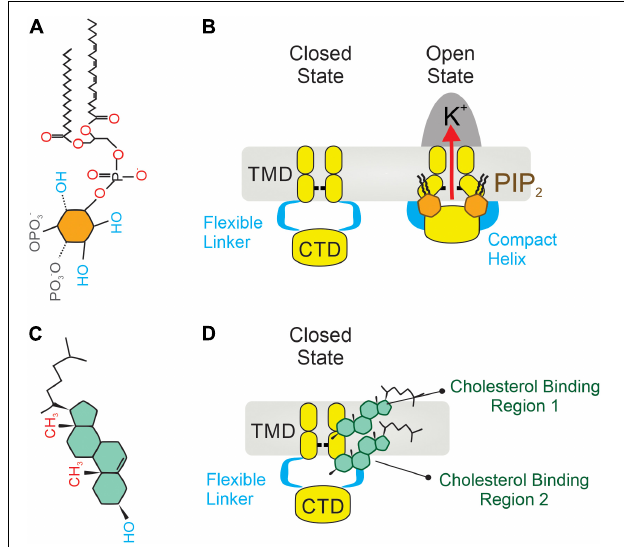
FIGURE 3 | Two integral membrane lipids, PIP 2 and cholesterol, bind to and regulate the activity of Kir2 channels. (A) Molecular architecture of a PIP 2 molecule, constituted by an inositol polar group, a phosphoglycerol backbone and two acyl chains. (B) Mechanism of Kir2 stimulation by membrane PIP 2 binding, which causes a change in the architecture of the flexible linker into a compact helix. Then the cytoplasmic domain (CTD) translates toward and becomes tethered to the transmembrane domain (TMD), which in turn mechanically opens the channel. (C) A cholesterol molecule contains three main parts: (1) tetracyclic carbon ring, (2) a polar 3 β -hydroxyl (OH) group, and (3) a short non-polar carbon chain. (D) Location of two non-annular hydrophobic cholesterol binding domains in Kir2 channels: one located in the center of the TMD (1), and the second at the interface between the TMD and the CTD (2). Upon direct cholesterol interaction, the hinging motion of the transmembrane pore helix changes, causing channel stabilization in a preferred closed (silent)